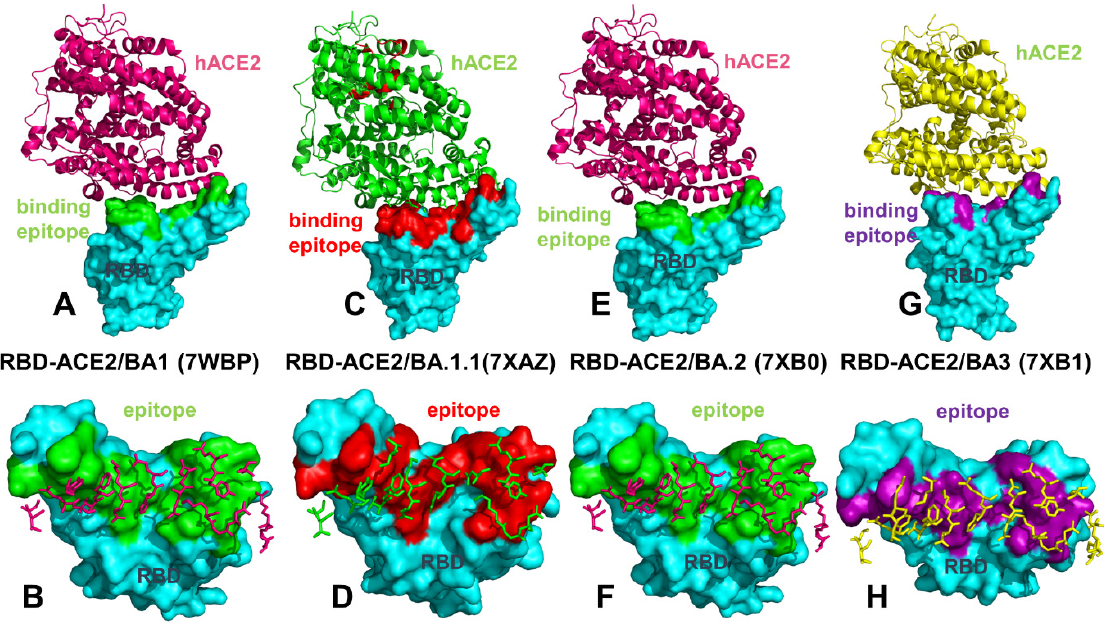
Figure 1. Structural organization and binding epitopes of the SARS-CoV-2-RBD Omicron BA.1, BA.1.1, BA.2 and BA.3 complexes with human ACE enzyme. ( A ) The cryo-EM structure of the Omicron RBD BA.1-ACE2 complex (pdb id 7WBP). The RBD is shown in cyan-colored surface and the bound ACE2 enzyme is in pink ribbons. ( B ) The RBD-BA.1 binding epitope is highlighted in green surface. The ACE2 binding residues are shown in pink sticks. ( C ) The cryo-EM structure of the Omicron RBD BA.1.1-ACE2 complex (pdb id 7XAZ). The RBD is shown in cyan-colored surface and the bound ACE2 enzyme is in green ribbons. ( D ) The RBD-BA.1.1 binding epitope is shown in red surface. The ACE2 binding residues are shown in green sticks. ( E ) The cryo-EM structure of the Omicron RBD BA.2-ACE2 complex (pdb id 7XB0). The RBD is shown in cyan-colored surface and the bound ACE2 enzyme is in pink ribbons. ( F ) The RBD-BA.2 binding epitope is shown in green surface and the ACE2 binding residues are shown in pink-colored sticks. ( G ) The cryo-EM structure of the Omicron RBD BA.3-ACE2 complex (pdb id 7XB1). The RBD is shown in cyan-colored surface and the bound ACE2 enzyme is in green ribbons. ( H ) The RBD-BA.3 binding epitope is shown in purple-colored surface and the ACE2 binding residues are shown in green sticks.